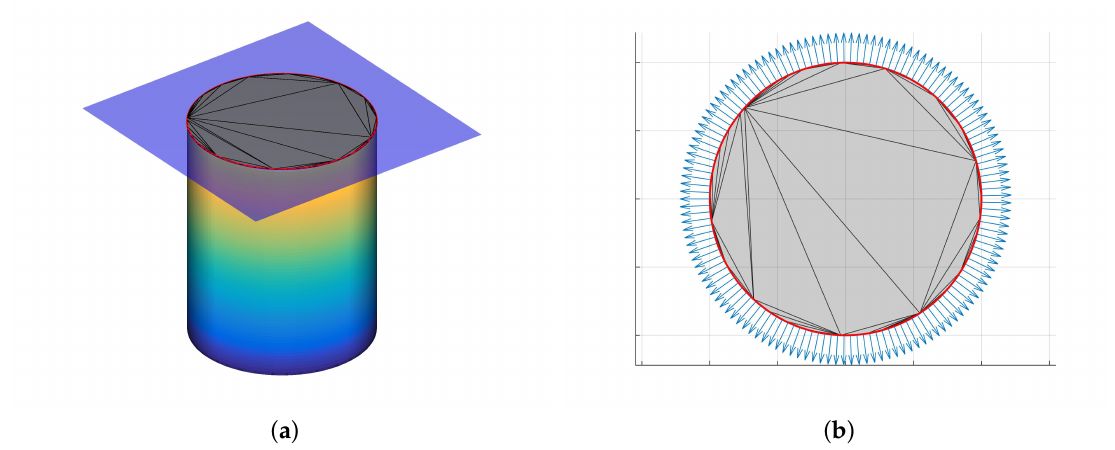
Figure 7. Cylinder dataset. Computation of a 2-manifold level set F and its oriented boundary contour ∂ f − 1 ( c ) . ( a ) Cylinder dataset; ( b ) 2-manifold region F and its oriented contour ∂ f − 1 ( c )